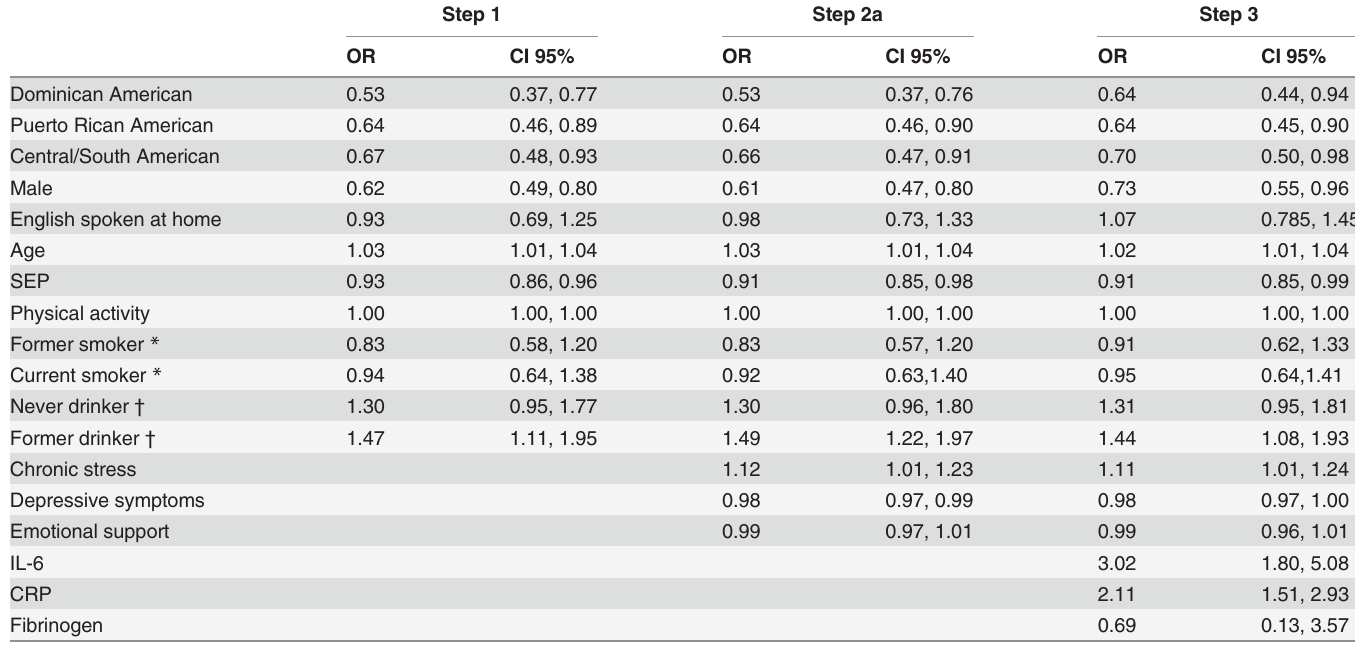
Table 2. Predictors for MetS